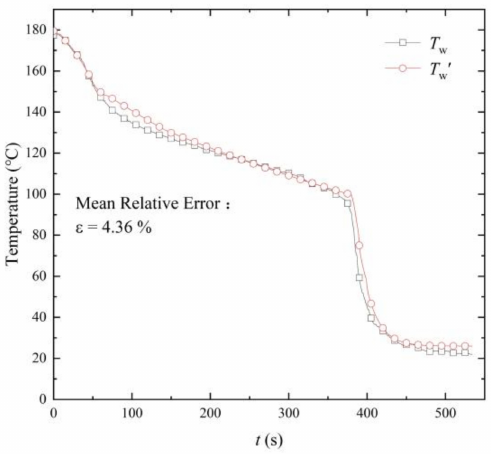
Figure 6. Comparison of T (cid:48) w and T w . The mean relative deviation is just 4.36%. So taking the Equations (1) and (2) as the calculation equations is